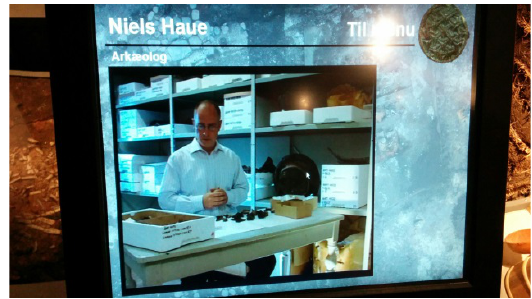
touchscreen. Lindholm Høje, Denmark. Photo: The author.